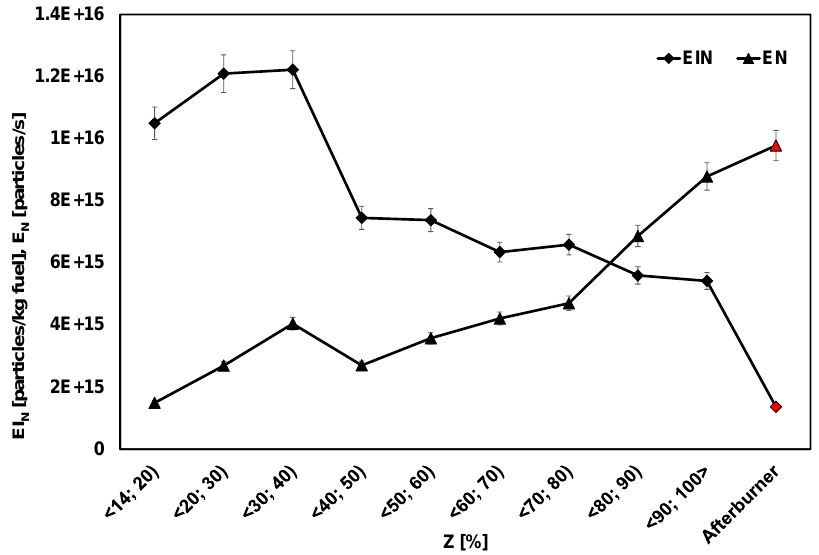
Figure 1. Particle Number Emissions Index (EI N ) and Particle Number Emissions Intensity (E N ) versus relative position of the power lever (Z).